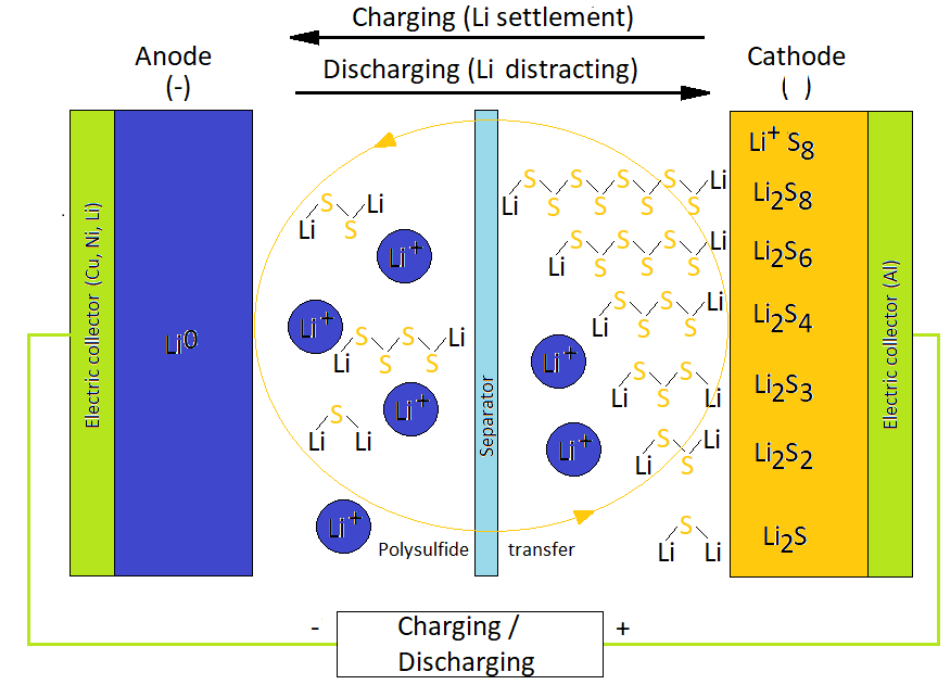
Figure 1. Li-S battery configuration employing organic liquid electrolyte [11].